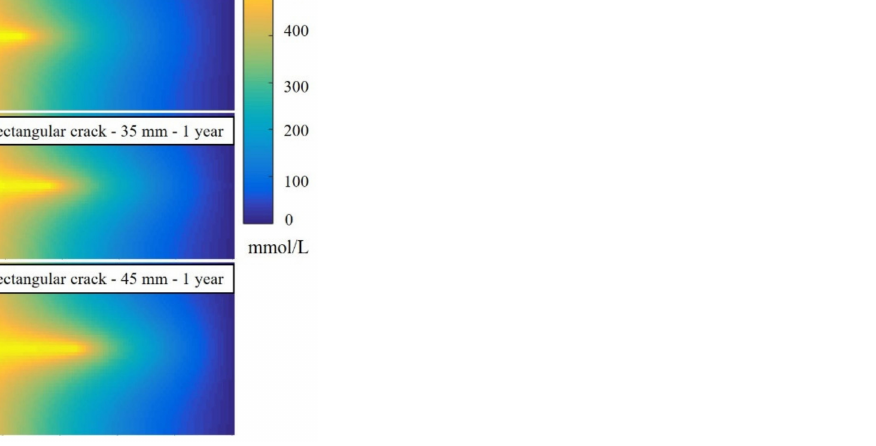
Figure 8. The simulated chloride concentration in cracked concrete with rectangular cracks after one year of immersion in NaCl